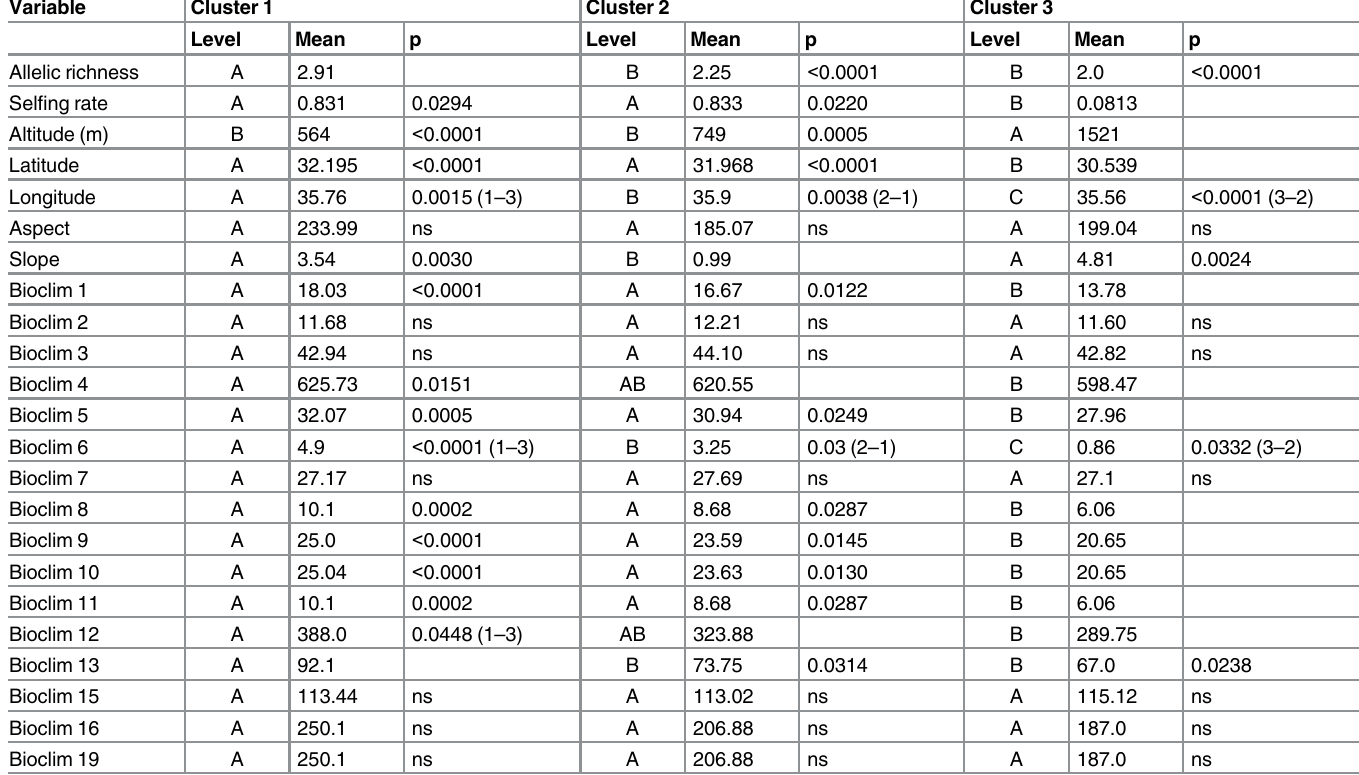
Table 5. Comparison of average values for geographical, geophysical and Bioclim variables, allelic richness and selfing rate at collecting sites among genetic clusters.